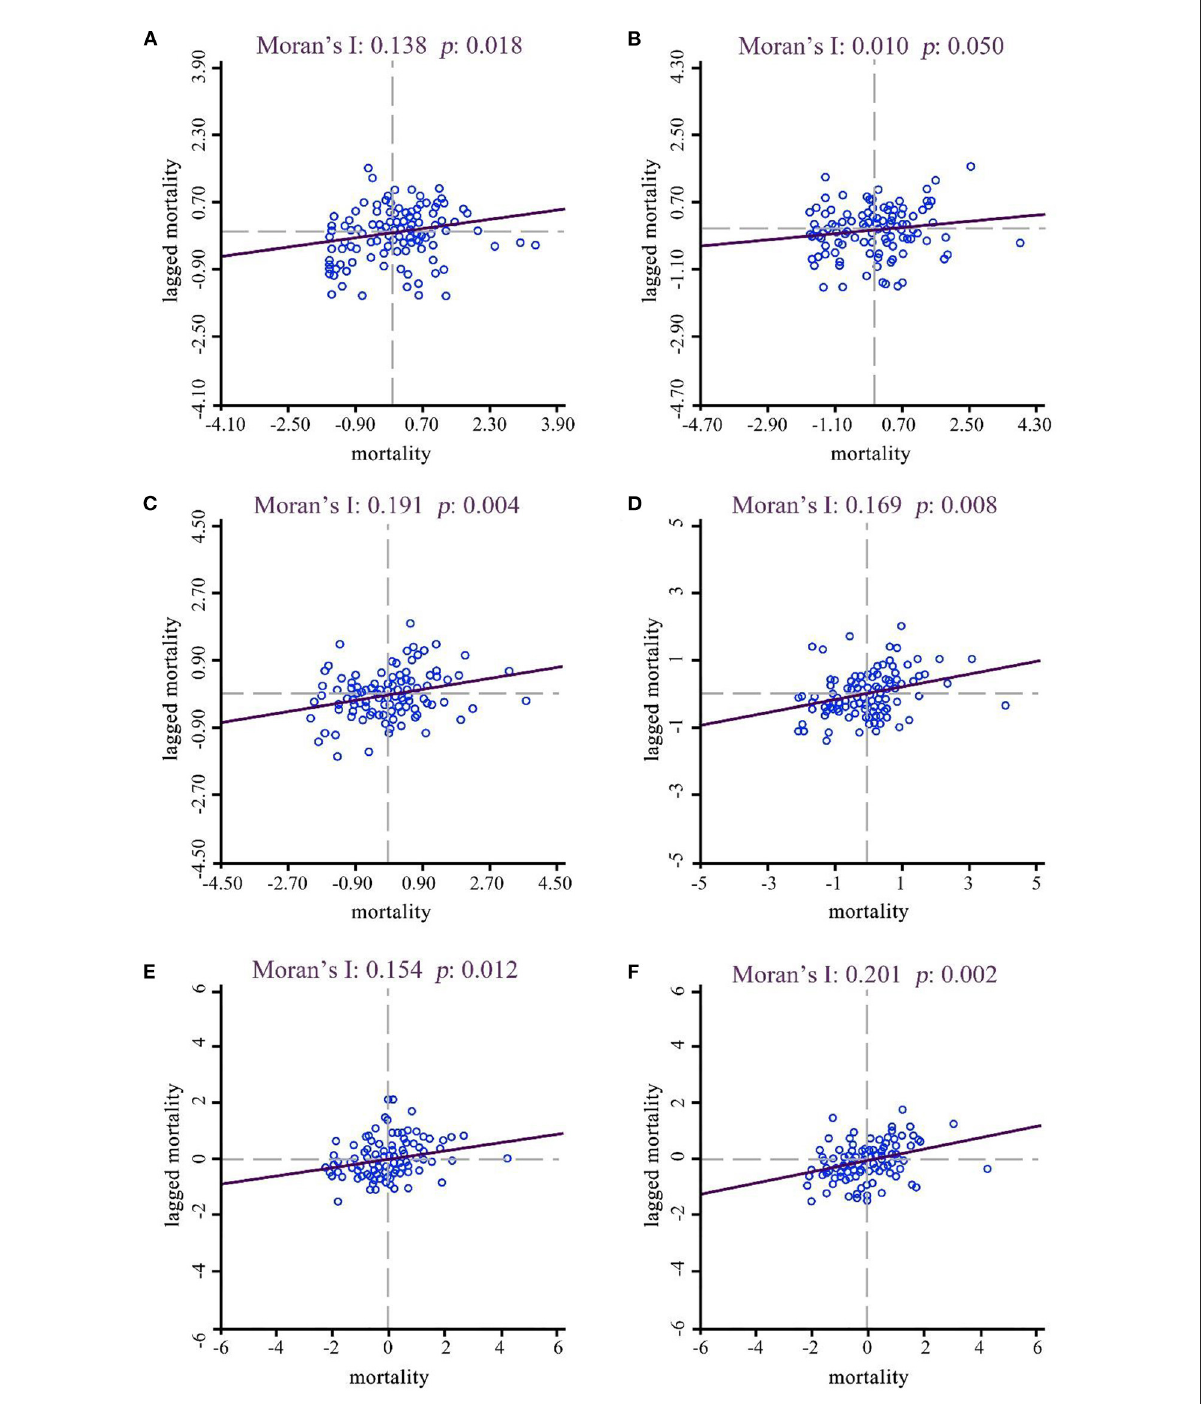
FIGURE4 Moran’s I scatter plots of liver cancer mortality in Yunnan, 2015–2019. (A–E) year 2015–2019, (F) year 2015–2019 on average.